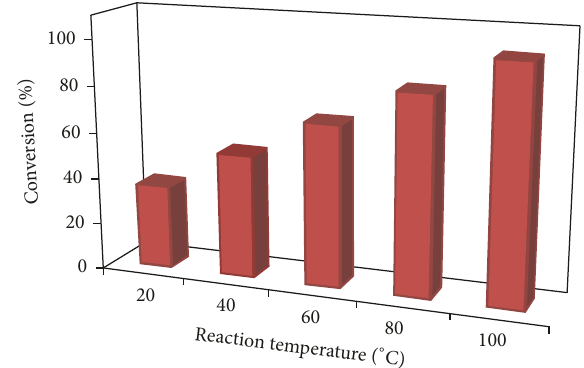
Figure 9: Catalytic performance of 1% ZnO function of reaction temperature.